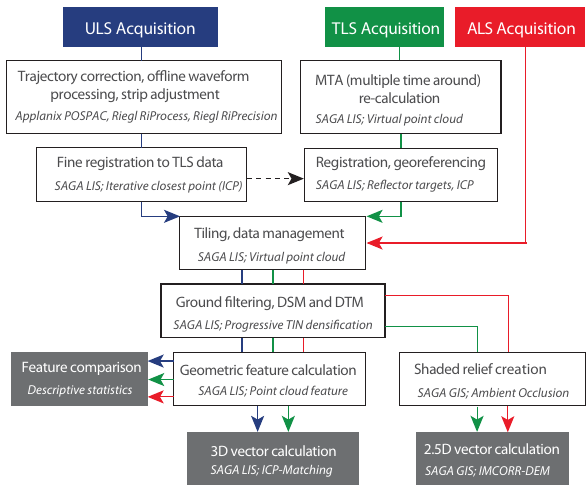
Figure 2. Workflow showing the main data processing